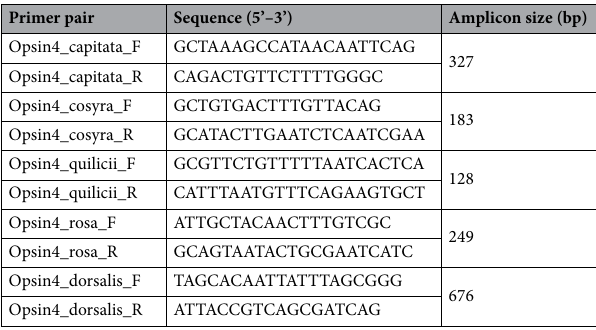
Table 1. List of primers designed for accurate species identification in the multiplex PCR